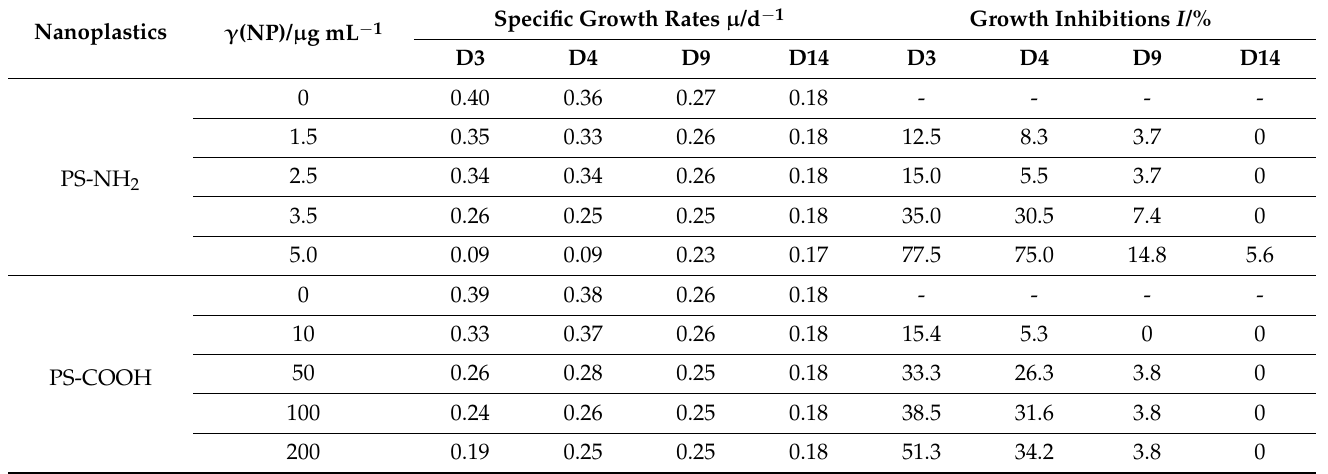
Table 1. Specific growth rates ( µ ) and growth inhibition ( I ) of Cylindrotheca closterium exposed to different concentrations of PS-NH 2 and PS-COOH NPs between day 3 (D3), day 4 (D4), day 9 (D9), day 14 (D14), and day